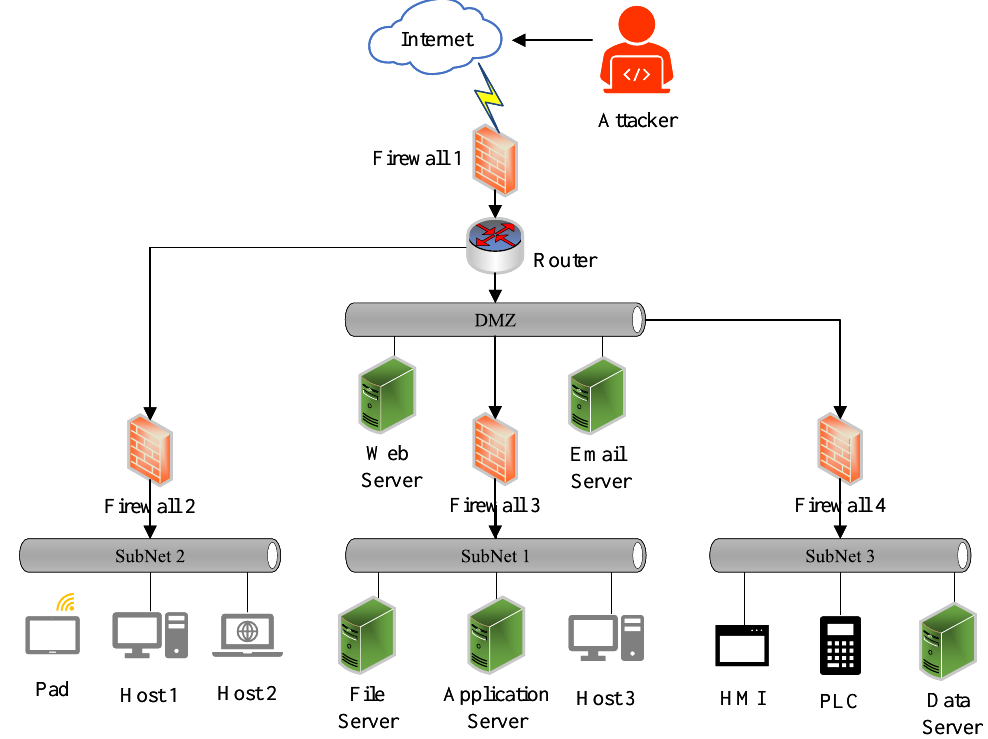
Figure 5. A general experiment network